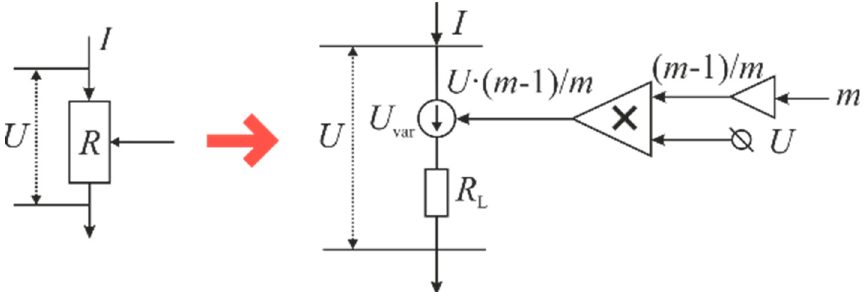
Figure A1. The circuit of the block of a variable resistor R in the chain of OSC2 that is used in the simulation (MatLab/Simulink).